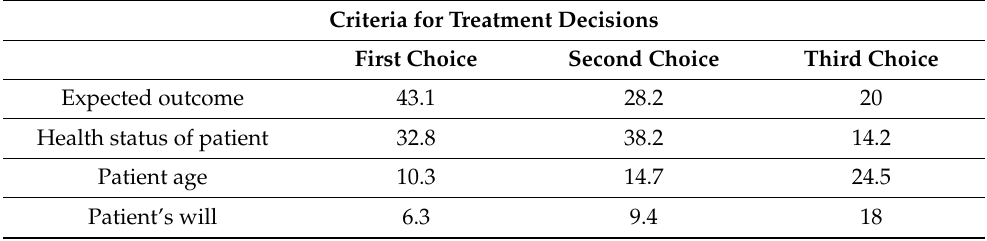
Table 4. The views of frontline HCP on what criteria, in the context of resource scarcity, should form the basis for treatment